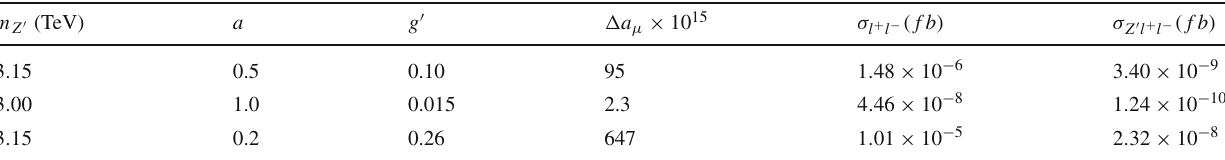
Table 1 The cross sections of Drell–Yan process pp → Z (cid:2) → (cid:2) + (cid:2) − and the associated production pp → Z (cid:2) (cid:2) + (cid:2) − at 13 TeV LHC. The corrections to muon g − 2 ( (cid:13) a μ ) are also given. The benchmark points